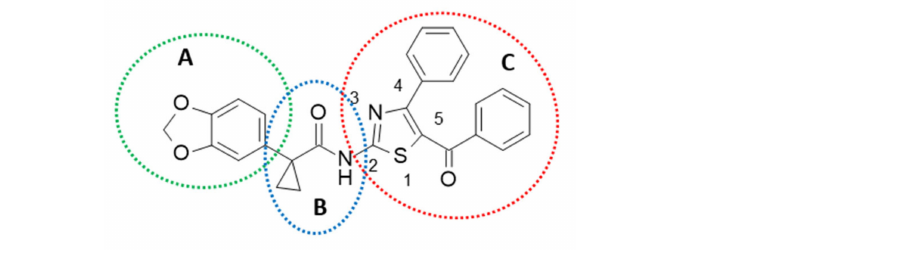
Figure 5. Sites of chemical modifications on the structure 2a to explore the SAR of the thiazole hybrids.